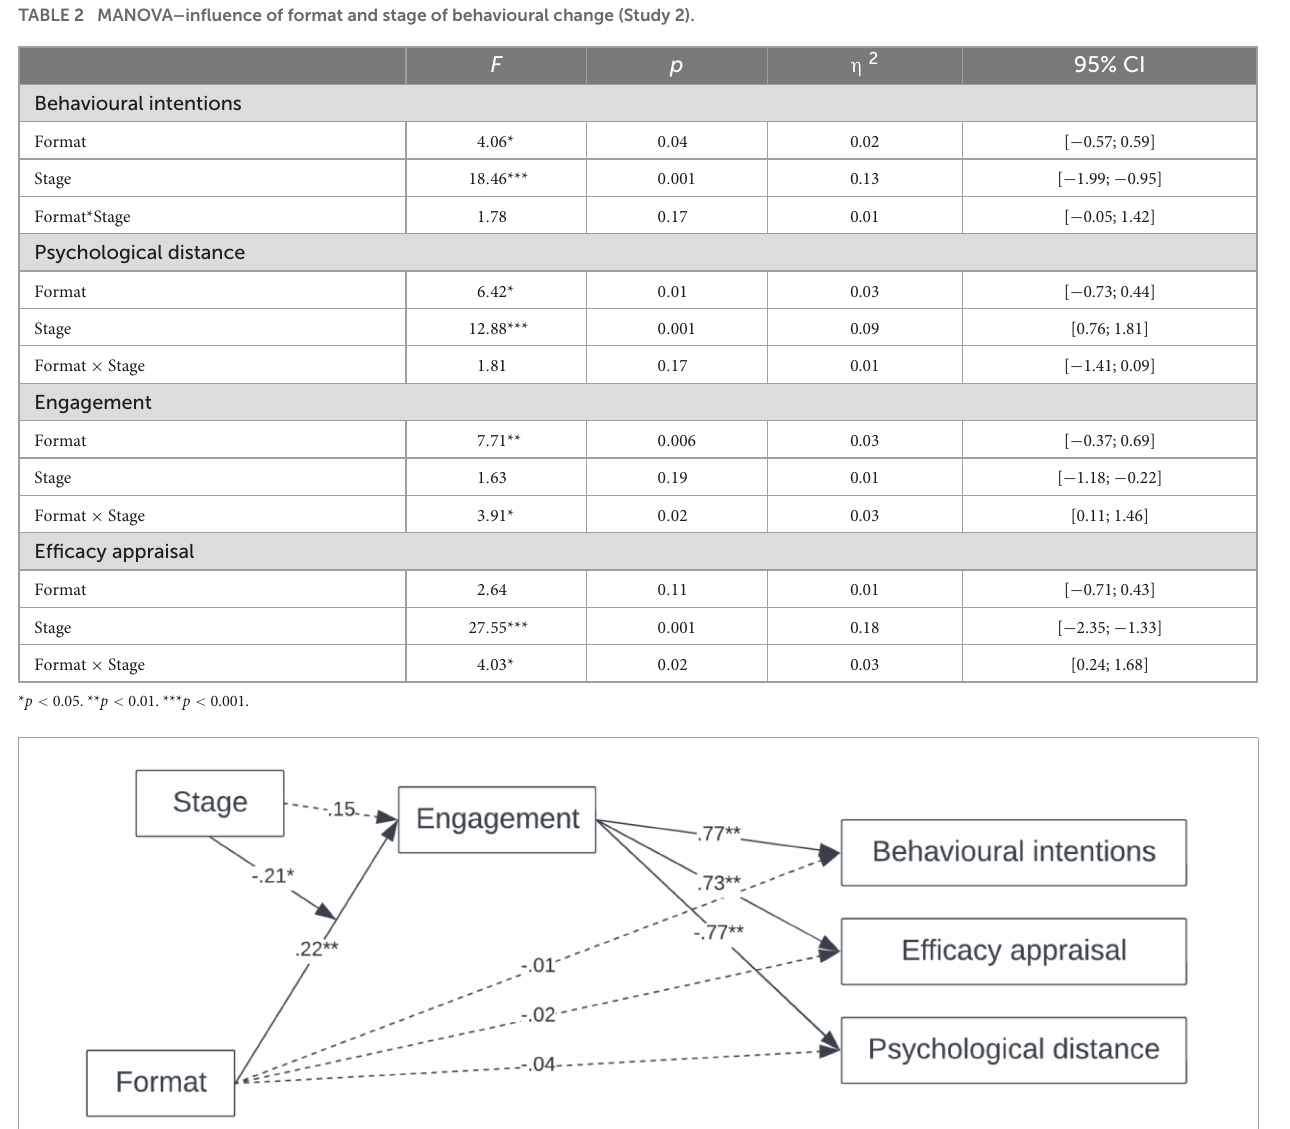
FIGURE1 Standardised structural relations; moderated mediation model (Study 2). * p < 0.05. ** p <